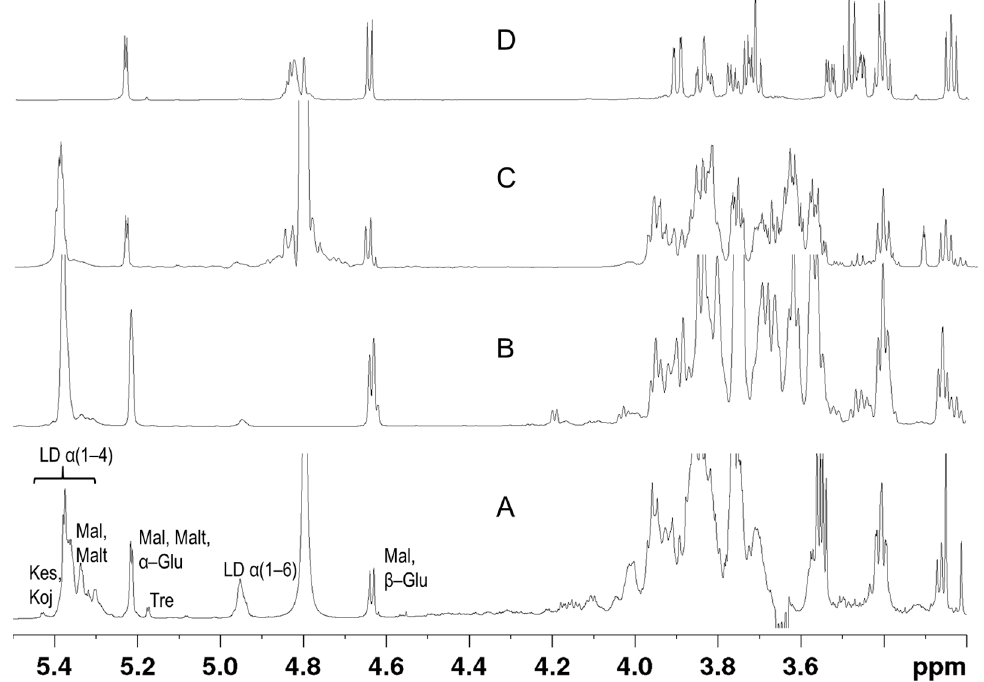
Figure 2. Shown are 800 MHz 1 H NMR spectra of beer ( A ), mash ( B ), starch hydrolysis with α -amylase ( C ), and starch hydrolysis with amyloglucosidase ( D ).